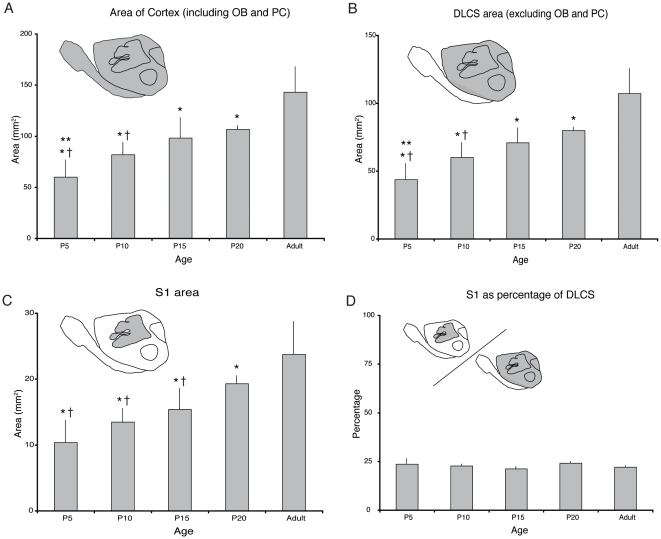
Measurements of different cortical areas.The shaded portion of the brain schematic represents the area being measured. A) The mean area (in mm2) of the cortex (including the dorsolateral cortical sheet, pyriform cortex, and olfactory bulb), B) dorsolateral cortical sheet (DLCS), (C) S1, and (D) the percentage of cortex occupied by S1. Note that the size of the complete cortical sheet, DLCS and S1 increases with age. However, the relative size of S1 as measured using architectonic boundaries is unchanged throughout development and adulthood. * - significantly different from adult. † - significantly different from P20. ** - significantly different from P15. Mean + s.d.